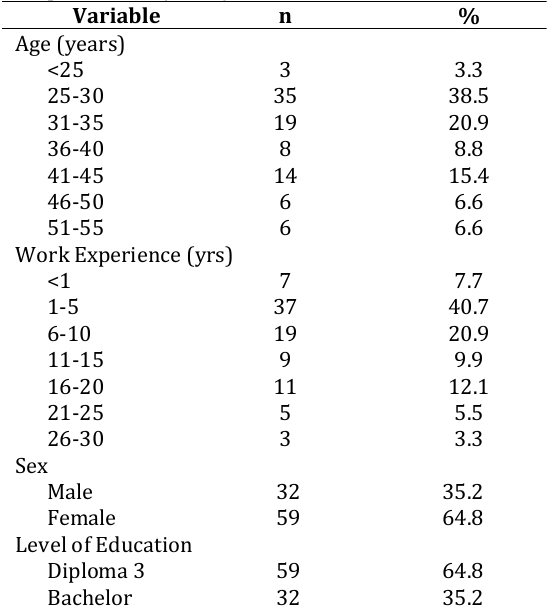
Table 1. Sociodemographic characteristic of